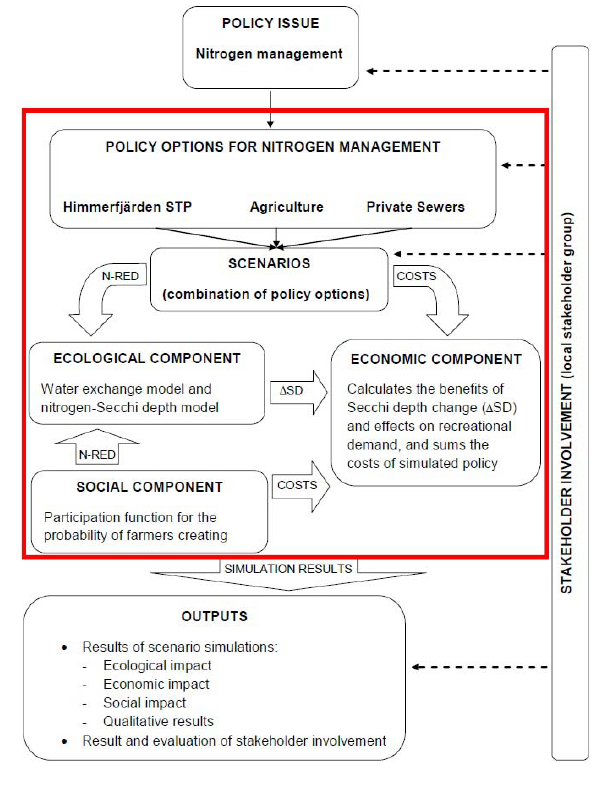
Fig. 2 . Conceptual model for coastal zone modeling in Himmerfjärden. The red square encloses the components in the simulation model. Solid arrows indicate the data input on which the simulations are based. Dashed arrows indicate where stakeholders were involved and influenced the model and research